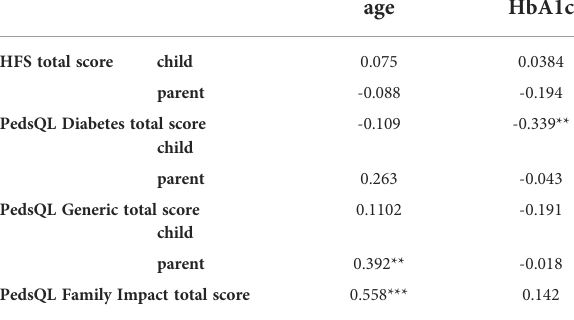
TABLE 3 Spearman correlation coef fi cient between age, metabolic control and questionnaire scores, *p< 0.05, **p< 0.01, ***p< 0.001. HFS, Hypoglycemia Fear Survey; PedsQL, Pediatric Quality of Life.